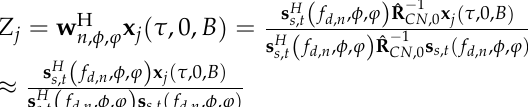
J denotes the covariance matrix smoothing times among sub-CPIs, and where s denotes the selection range of training samples in the j -th sub-CPI, obtained by the sta- J can be decreased to reduce the tistical analysis of secondary data. Note that the s computational complexity in practice, because the statistical homogeneity of the selected training samples have already been improved for the covariance matrix smoothing. By updating the CCM with selected stationary training samples in the covariance matrix smoothing, the aforementioned long-CPI induced clutter suppression performance deg- radation is avoided. f s is designed to be consistent in the STAP filters among sub-CPIs, in The ( ) , t d n f and the target Dop- which the mismatched Doppler frequency difference between , d n pler frequency has no impact on the target Doppler history of STAP outputs. In specific, considering the case that the subspaces of the target and clutter are orthogonal, we can obtain ,0 and the STAP output within , the j -th sub-CPI is expressed as